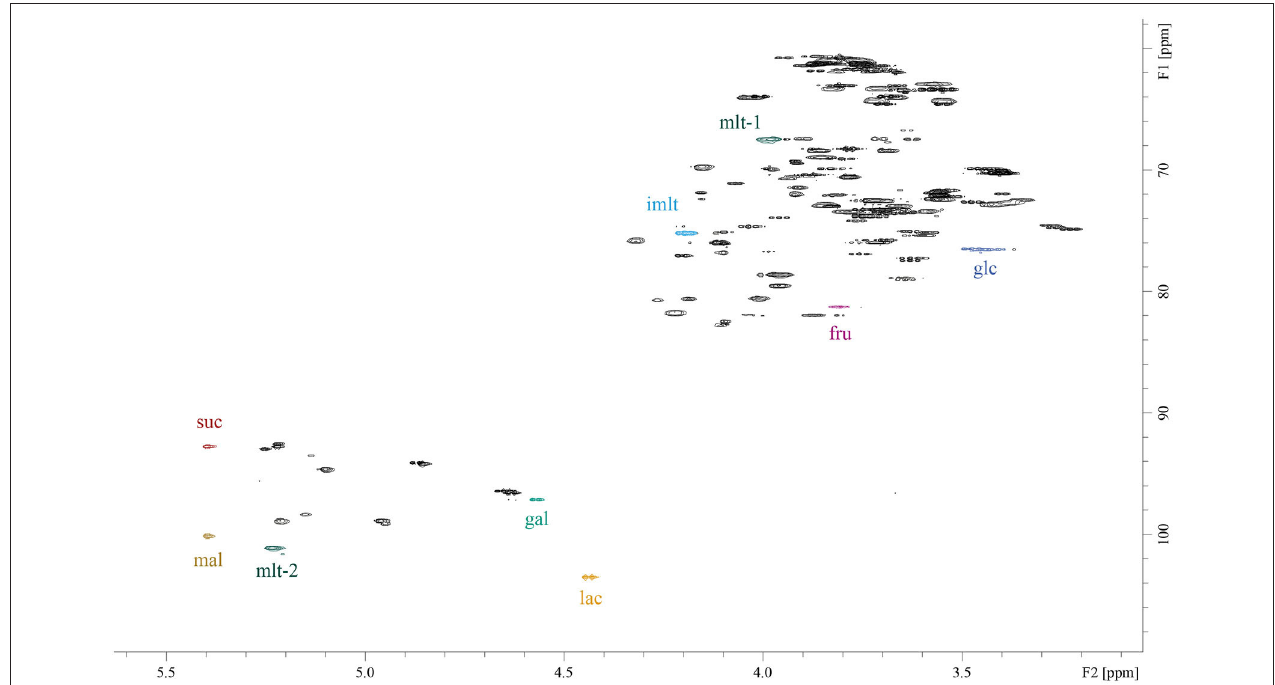
FIGURE 1 | HSQC-spectrum of an aqueous solution of the sugars D -glucose (glc), D -galactose (gal), D -fructose (fru), sucrose (suc), lactose (lac), maltose (mal), isomaltulose (imlt), and maltulose (mlt). Chemical shifts of the selected signals for quantification are quoted in the Section NMR Experiments. The measurement was carried out with the following acquisition parameters: pulse sequence “hsqcetgp”, two scans, size of time domain 1,024 in both dimensions, D 1 = 1.5 s. HSQC: heteronuclear single quantum coherence.